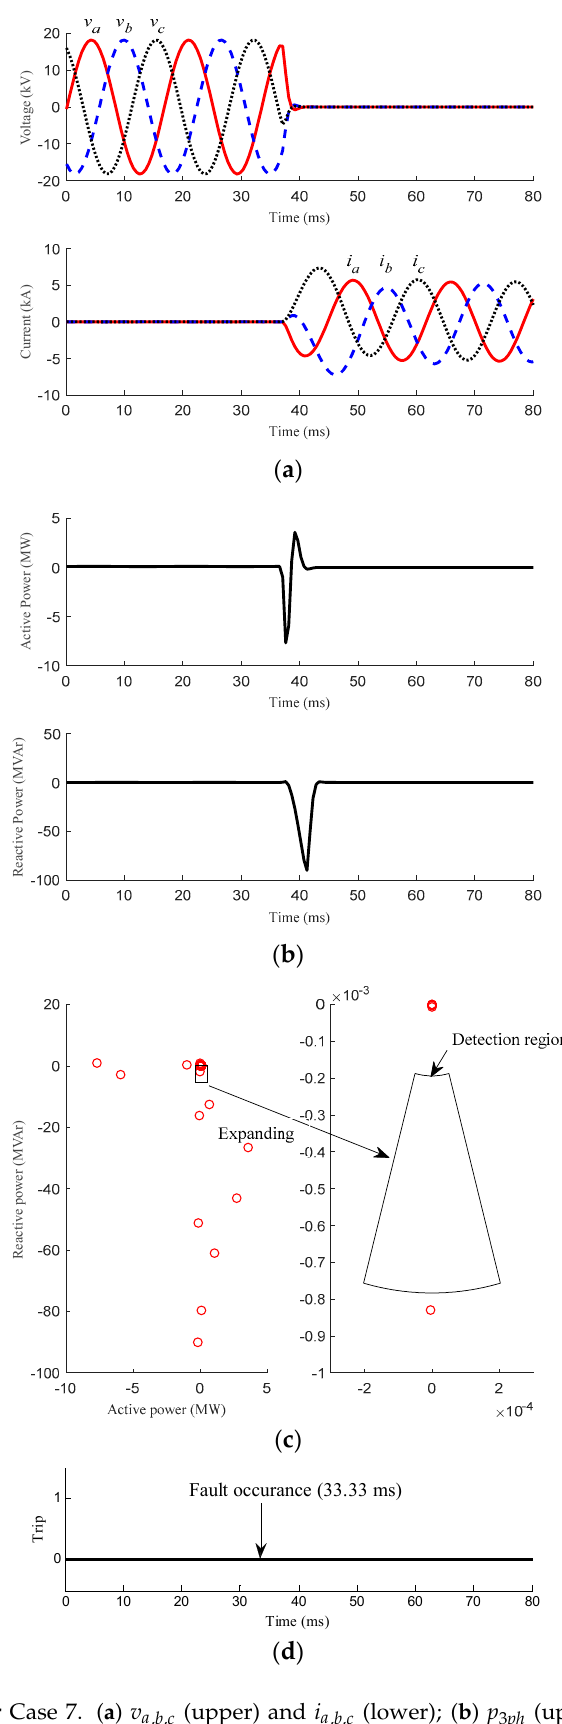
Figure 9. Results for Case 7. ( a ) v a , b , c (upper) and i a , b , c (lower); ( b ) p 3 ph (upper) and q 3 ph (lower); ( c ) Trajectories of the point ( p 3 ph , q 3 ph ); ( d ) Islanding detection signal.